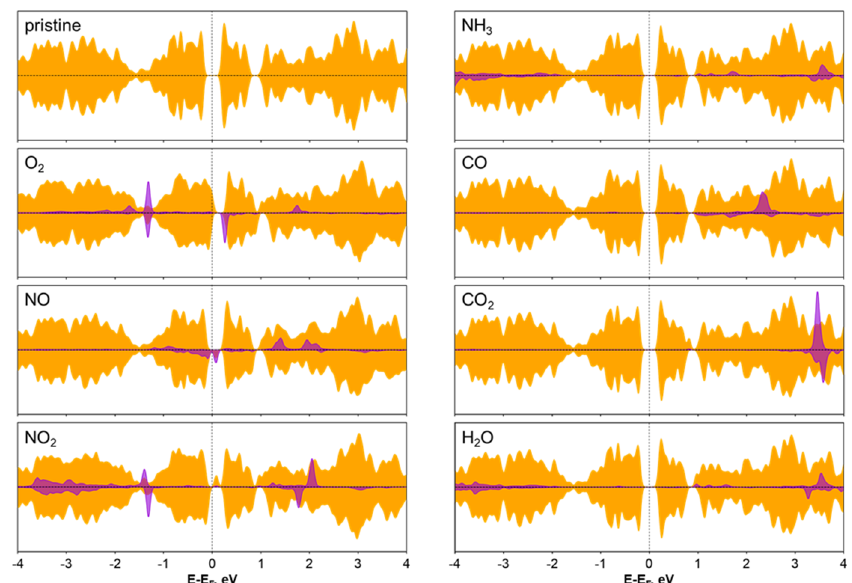
Figure 3. The density of electronic states of the V 3 S 4 monolayer before and after the adsorption of CO, CO 2 , H 2 O, O 2 , NH 3 , NO, and NO 2 gas molecules. Orange and violet colors denote the contribution from the V 3 S 4 monolayer and gas molecules, respectively. The Fermi level shifted to zero. The contribution from gas molecules was enlarged by 4 times for CO, CO 2 , O 2 , NO, and NO 2 molecules and by 20 times for the H 2 O and NH 3 molecules.